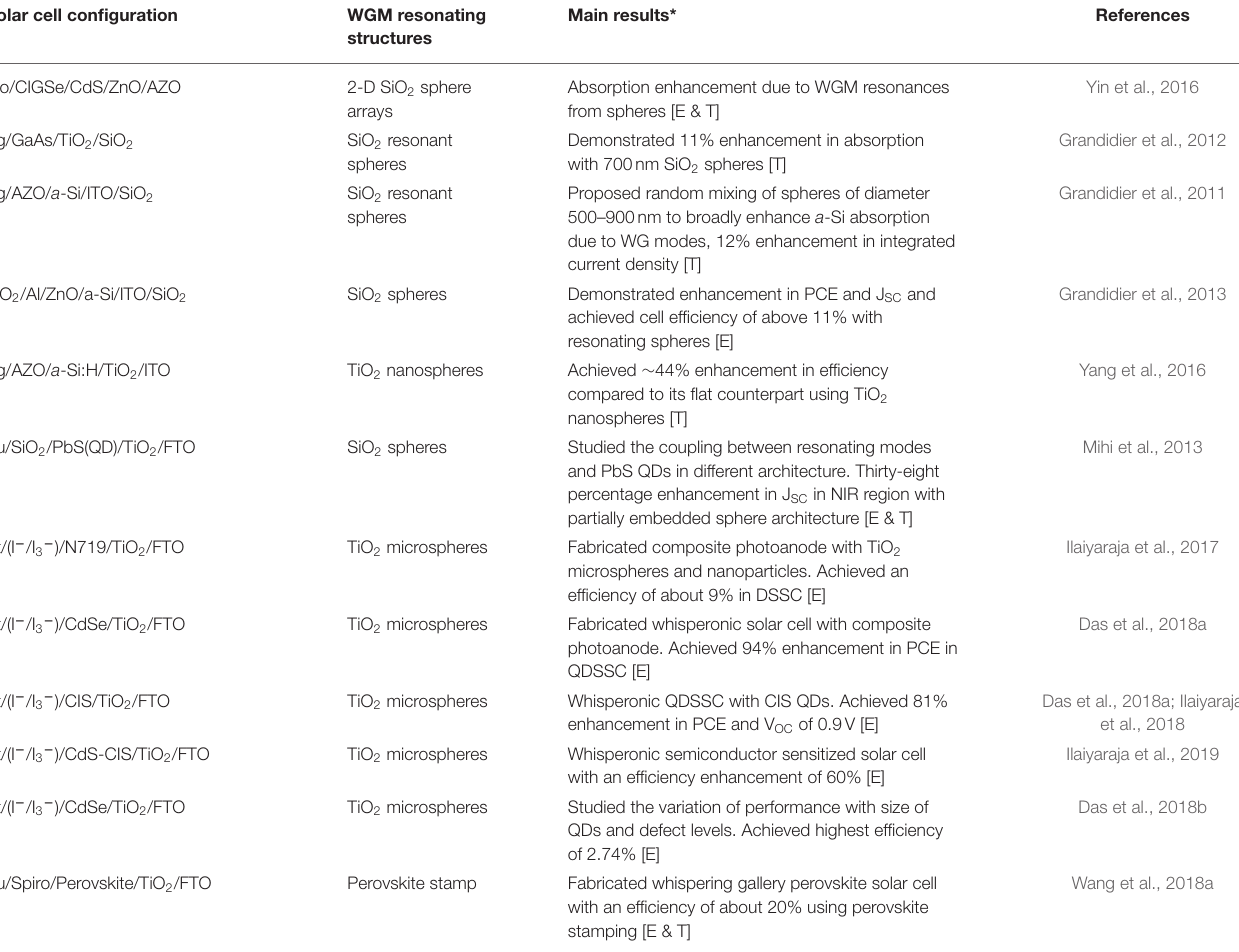
TABLE 1 | Solar cells using whispering gallery resonating structures to enhance power conversion